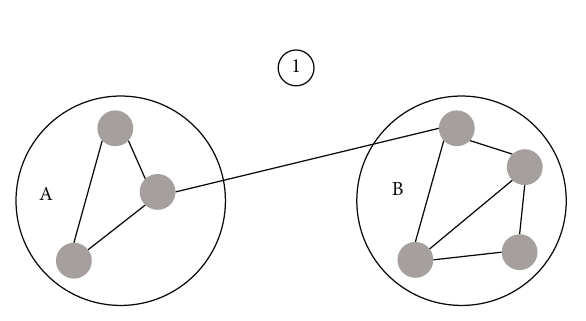
Figure 4: Isolated nodes without edges.